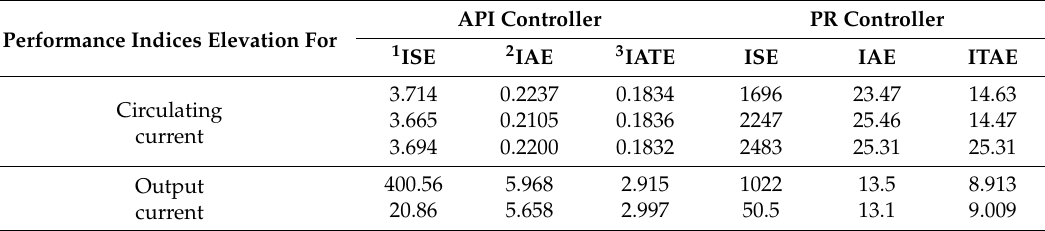
Table A2. Performance indices